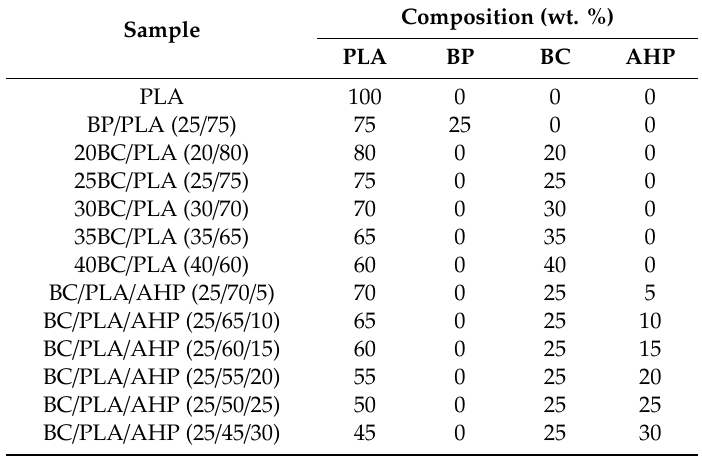
Table 1. The formulation of BP / PLA), (BC) / PLA, BC / PLA / AHP composites. Composition (wt. Sample